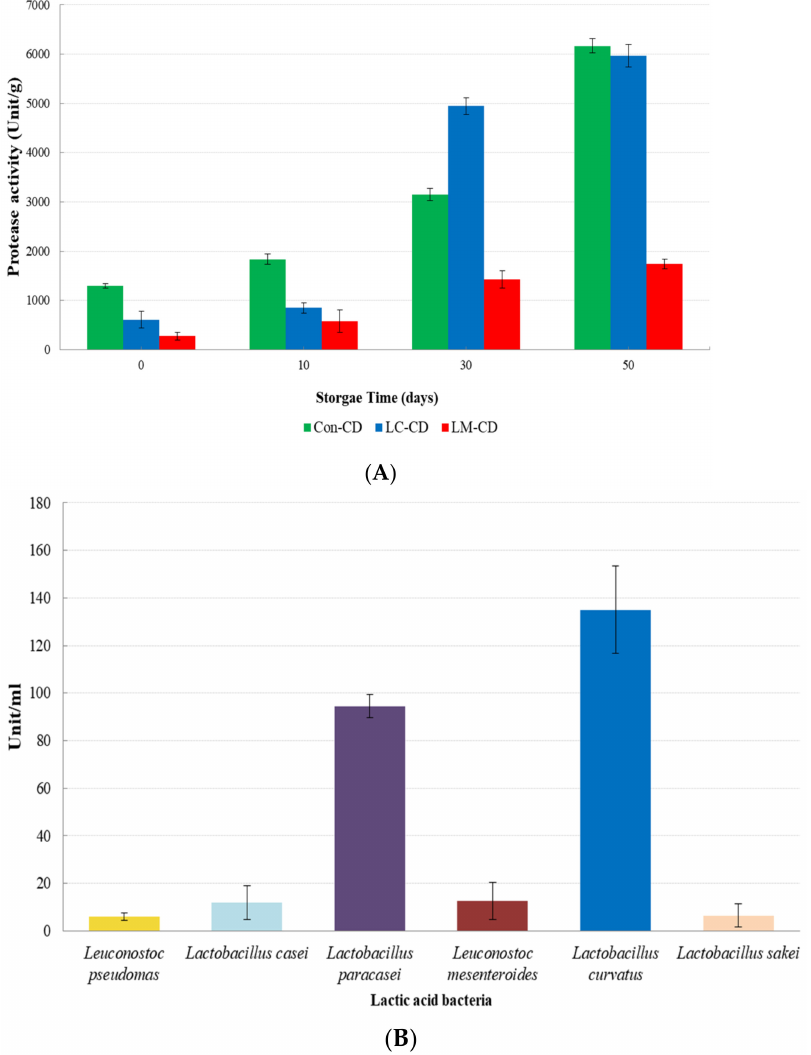
Figure 7. Proteolytic activites of LAB isolates and cheese- ddukbokki rice cake samples: ( A ) Cheese- ddukbokki rice cake samples at 10 ◦ C for 50 days; ( B ) six LAB strains isolated from cheese- ddukbokki rice